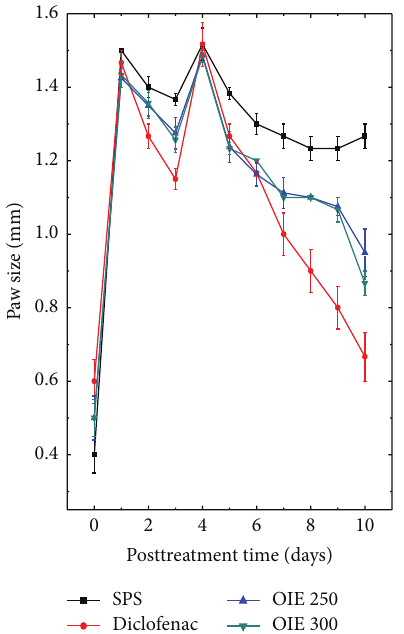
Figure 1: Effect of ethanol extract of Oroxylum indicum on the formalin induced inflammation in mice